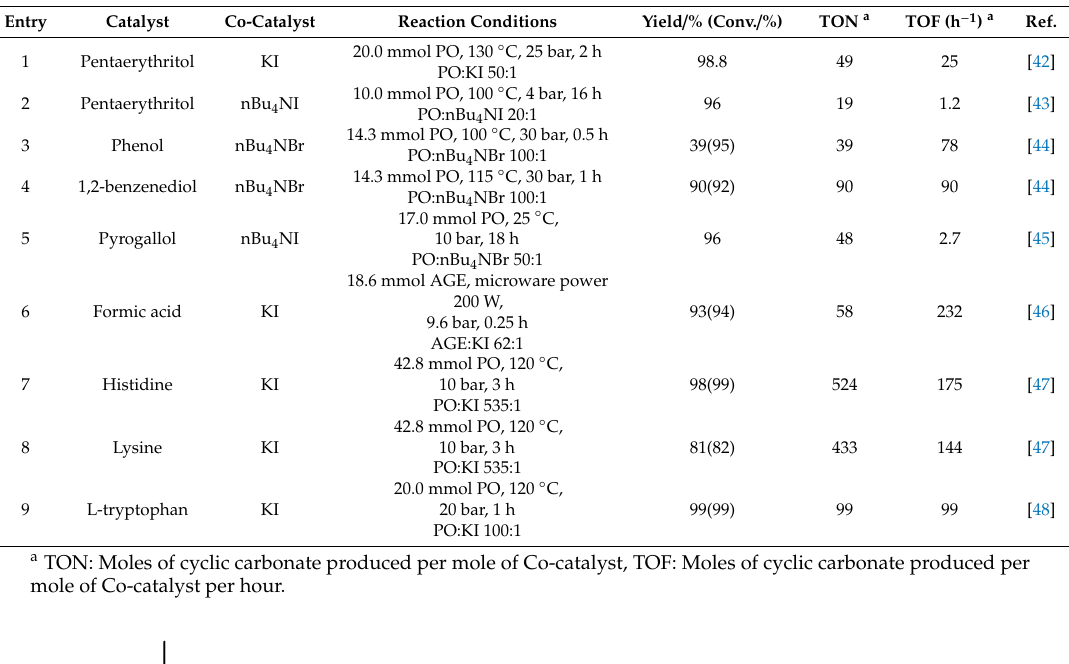
Table 1. Summary of reaction conditions and yields for epoxides conversion to cyclic carbonates using HBD / co-catalysts (propylene oxide (PO), allyl glycidyl ether (AGE)).